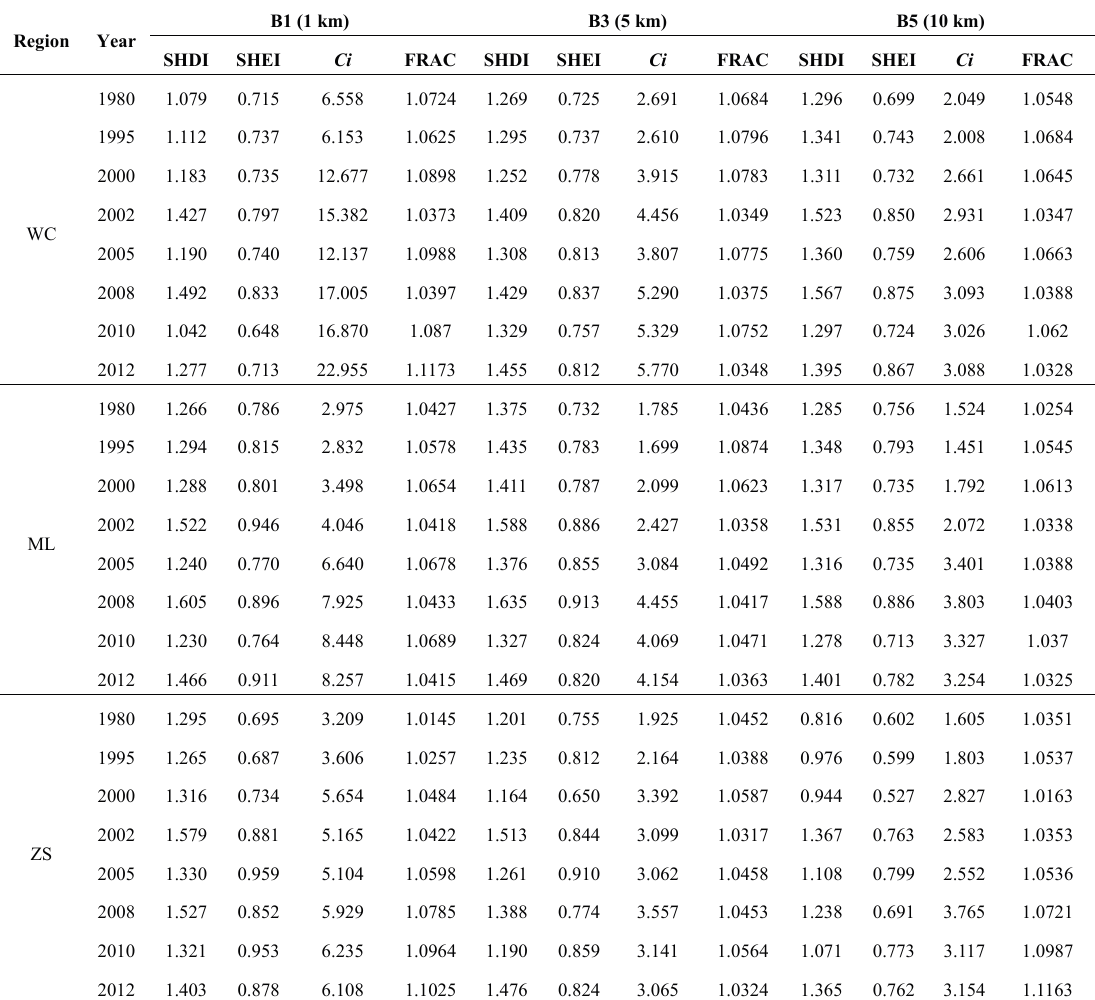
Table 2 . Change tendencies of landscape indices among different buffer